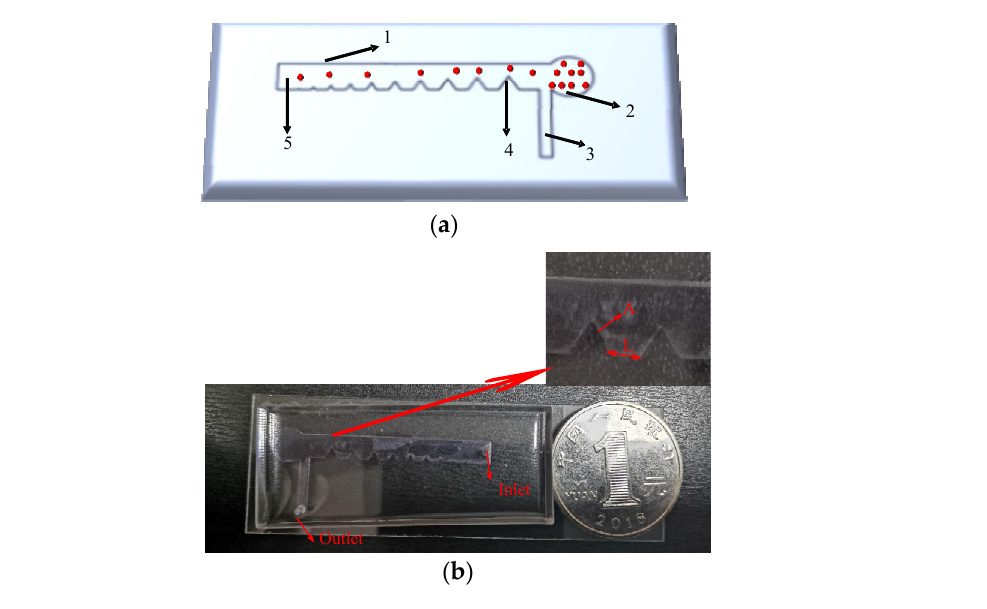
Figure 2. Structure diagram of microfluidic chip: ( a ) Two-dimensional structure,1. Plane structure, 2. Collection tank, 3. Channel 1, 4. Internal rib structure, 5. Channel 2; ( b ) Physical picture of the microfluidic chip, A and L represent the side length of internal rib structure and the internal rib structure spacing, respectively.